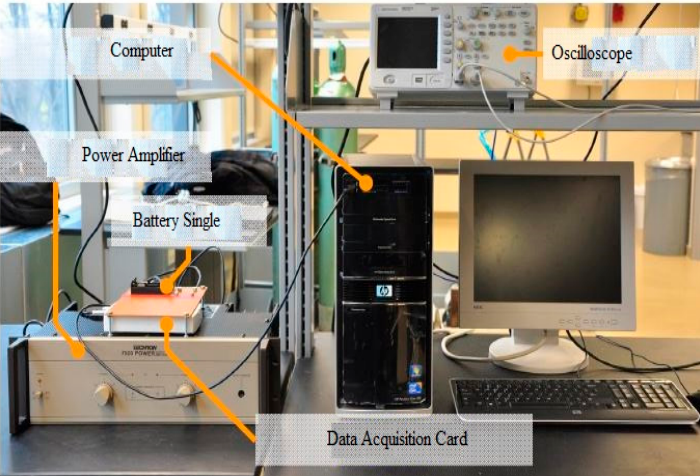
Figure 2. The physical layout of the battery testing system.